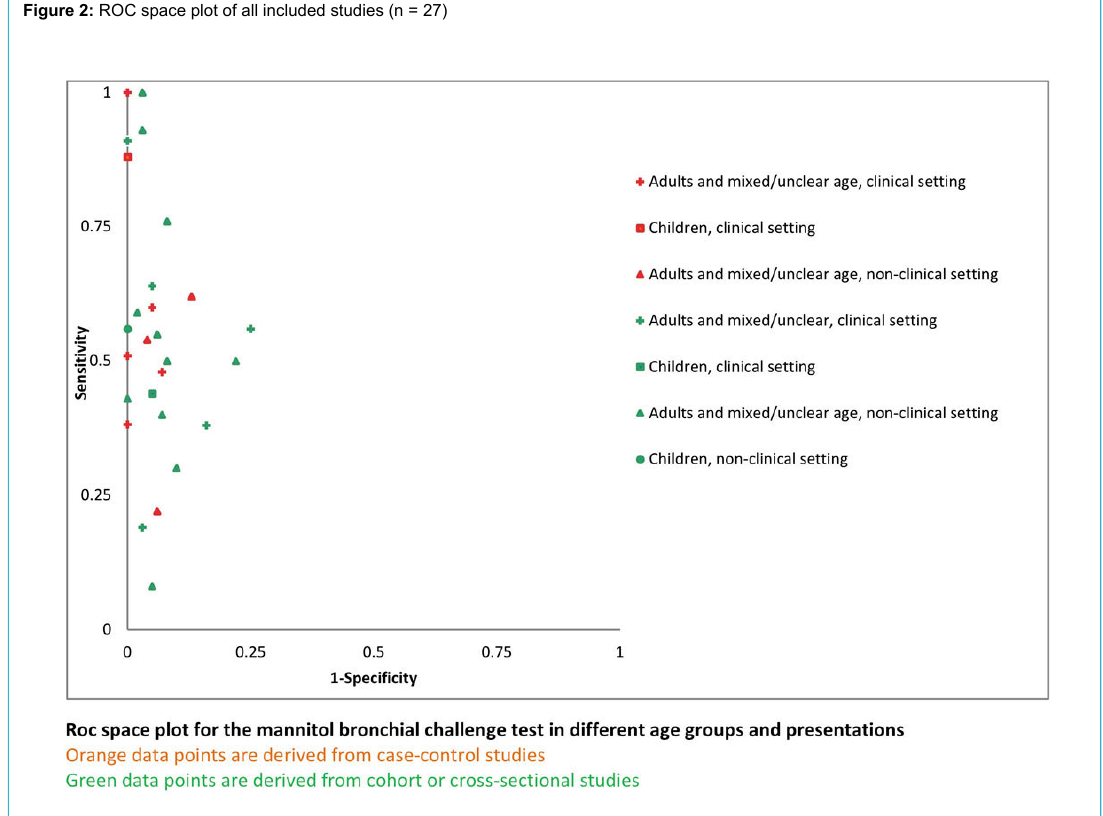
Figure 2: ROC space plot of all included studies (n =